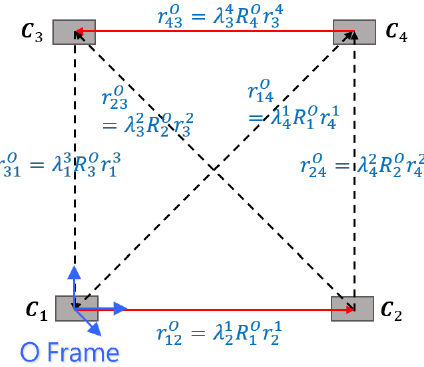
Figure 8. The geometry between consecutive images.